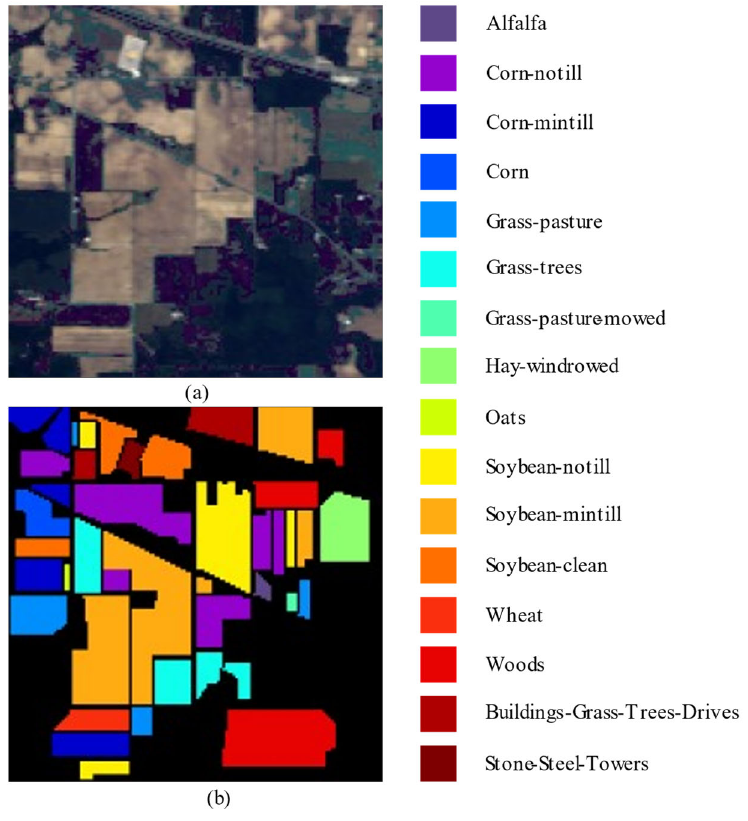
Figure 4. Indian Pines dataset. ( a ) Pseudocolor image; ( b ) ground truth.